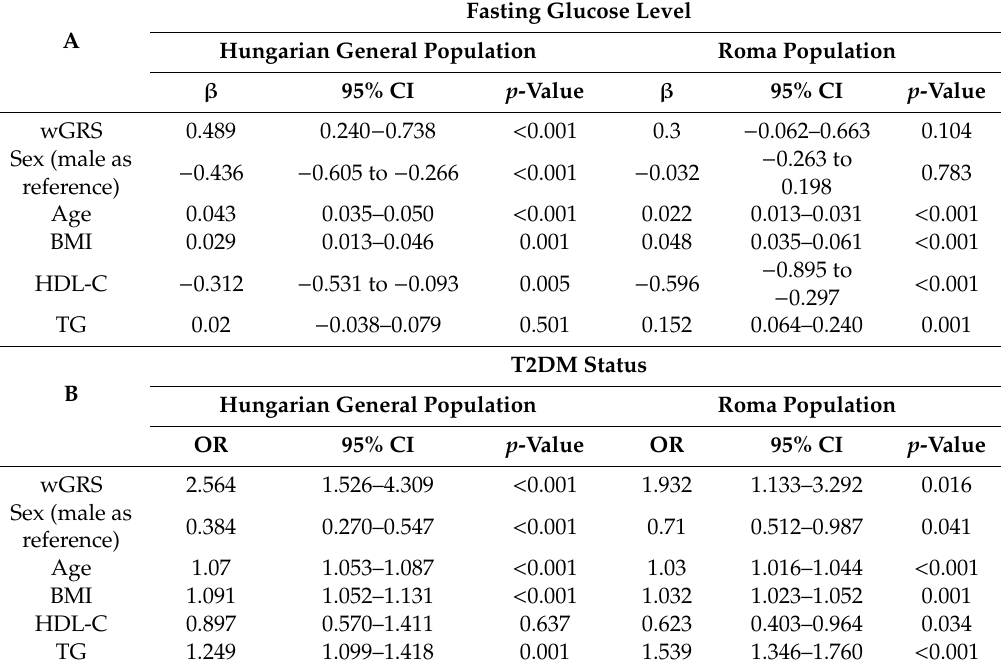
Table 6. Association of weighted GRS (wGRS) with fasting glucose level ( A ) and T2DM status ( B ) by study groups. The association was evaluated under adjusted regression models (sex, age, BMI, HDL-C and TG